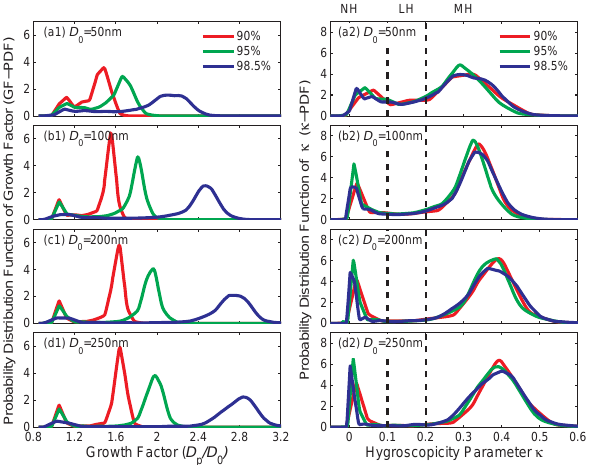
Fig. 2. Averaged probability distribution functions of (a1–d1) : growth factor (GF-PDF); (a2–d2) : hygroscopicity parameter κ ( κ - PDF); dashed lines represent the boundaries of the three defined hygroscopic groups; data were averaged over the whole period of HaChi summer